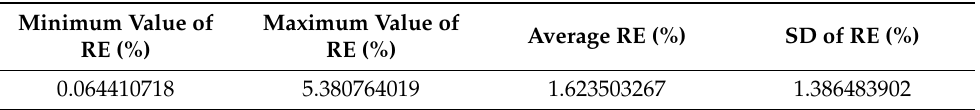
Table 2. Error Analysis of the data prediction for the Infected population.